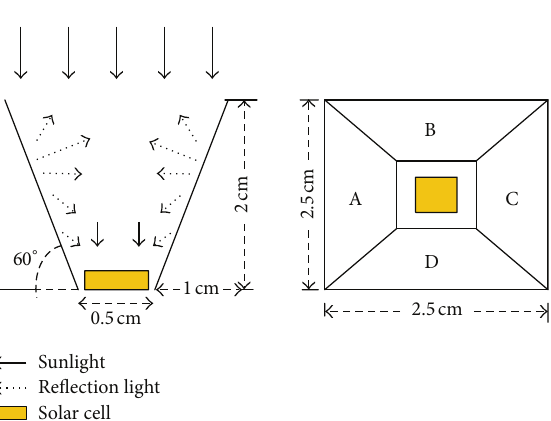
Figure 2: The output power of mechnism (B) and mechainsm (D).